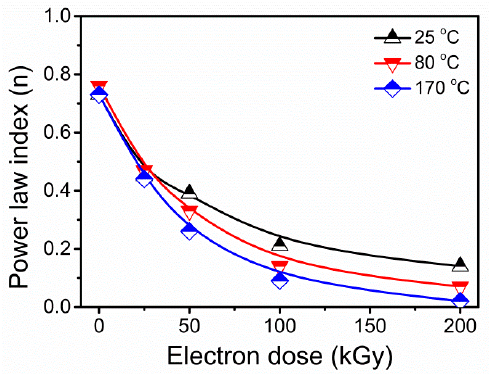
Figure 8. Power law index (n) for mNR irradiated at 25 °C, 80 °C, and 170 °C with the dose ranging from 0 to 200 kGy .